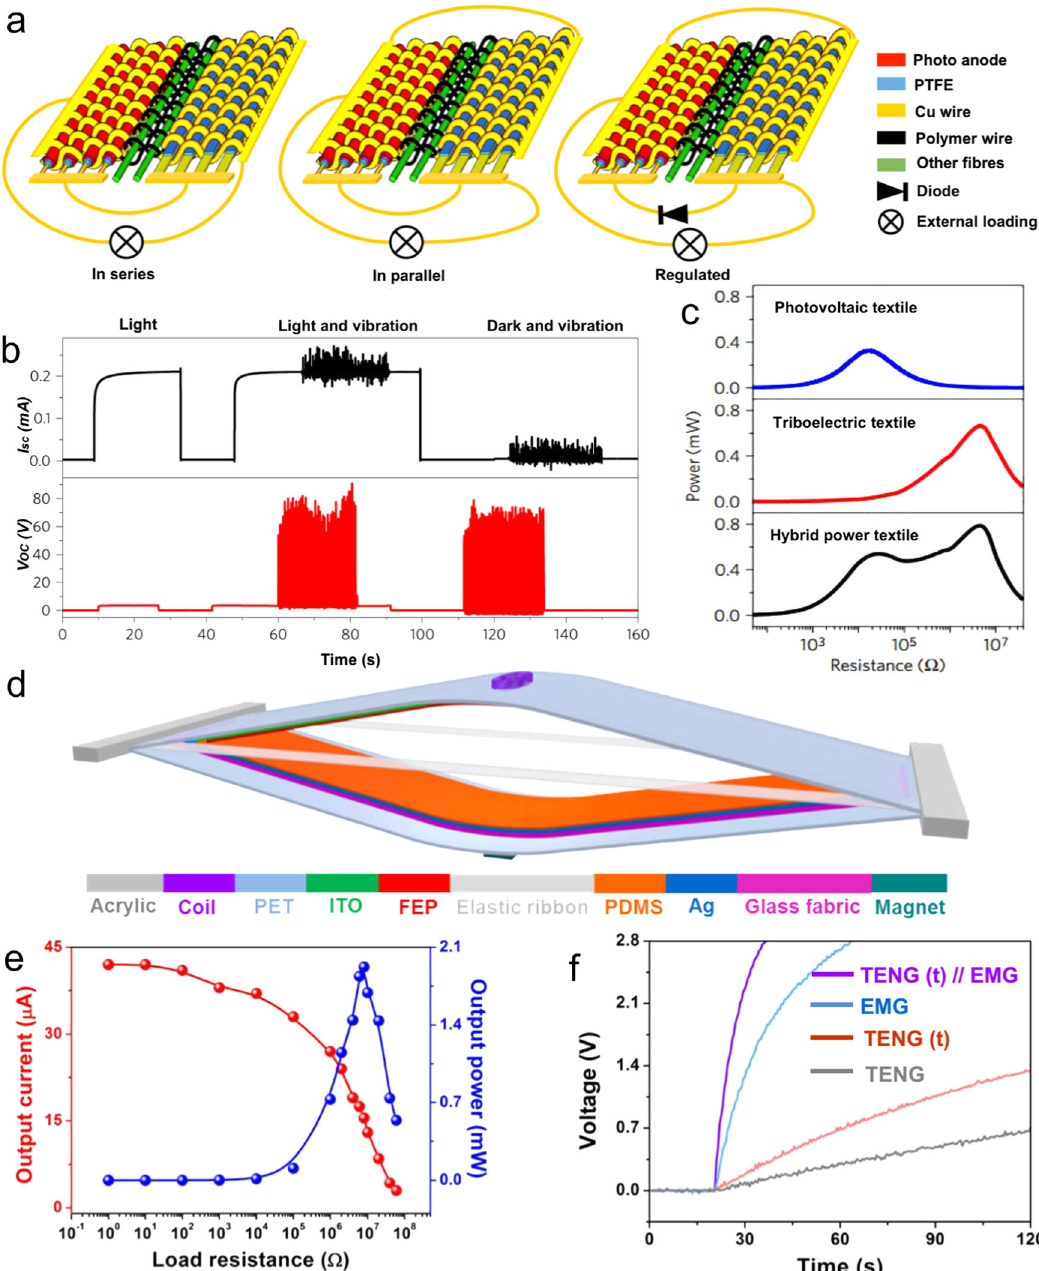
Fig. 5 a Schematic diagram of the hybrid energy cell and three connection mode. b Output signal under different circumstances. c Dependence of the output power on hybrid cells and individual cell. Reproduced with permission. 33 Copyright 2016 Nature Publishing Group. d Schematic diagram of the hybrid nanogenerator. e Dependence of the output power and voltage on the loading resistance. f Measured voltage of the capacitor with different generators. Reproduced with permission. 34 Copyright 2014 American Chemical